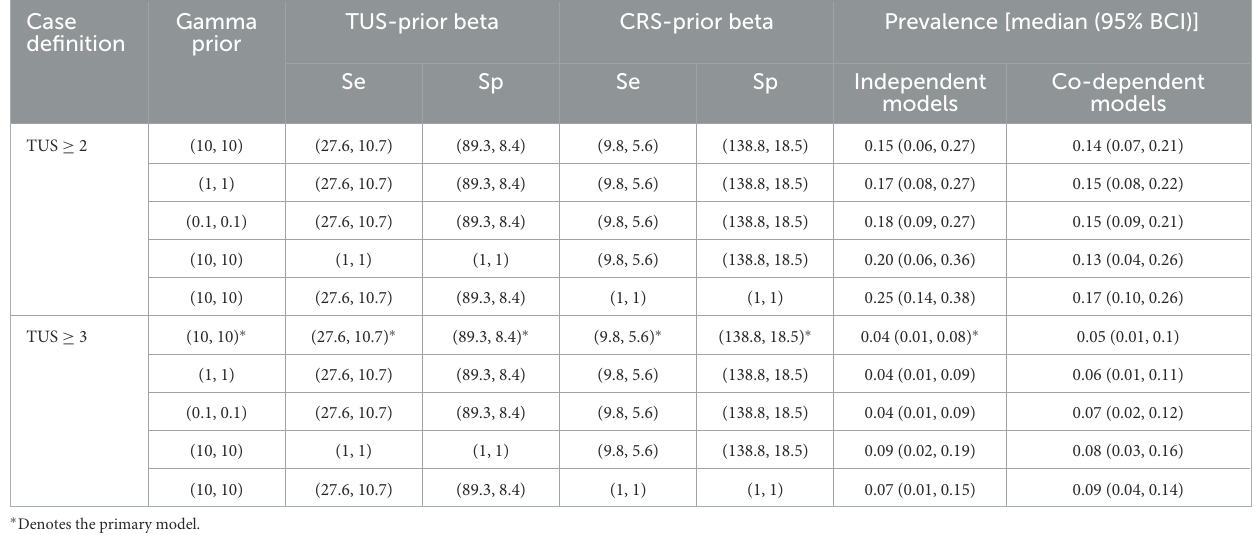
TABLE 3 The median prevalence and Bayesian credible interval (95% BCI) for each of the models undertaken as part of the sensitivity analysis, TUS and CRS and gamma priors, the TUS case definition and model dependency.